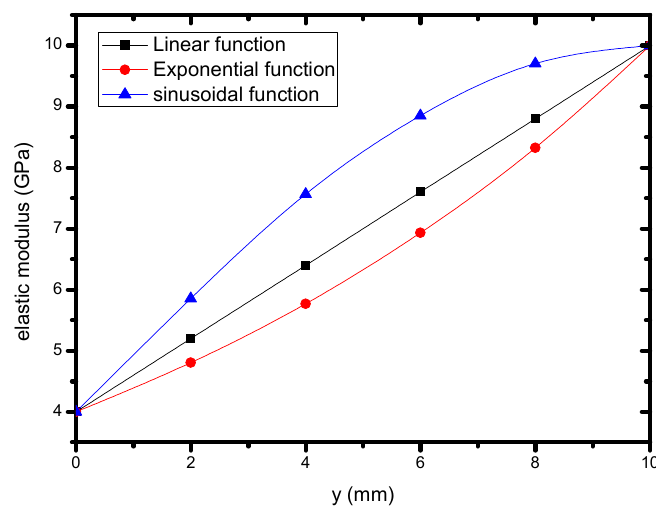
Figure 8. The variation of gradient properties of different FGM coatings.